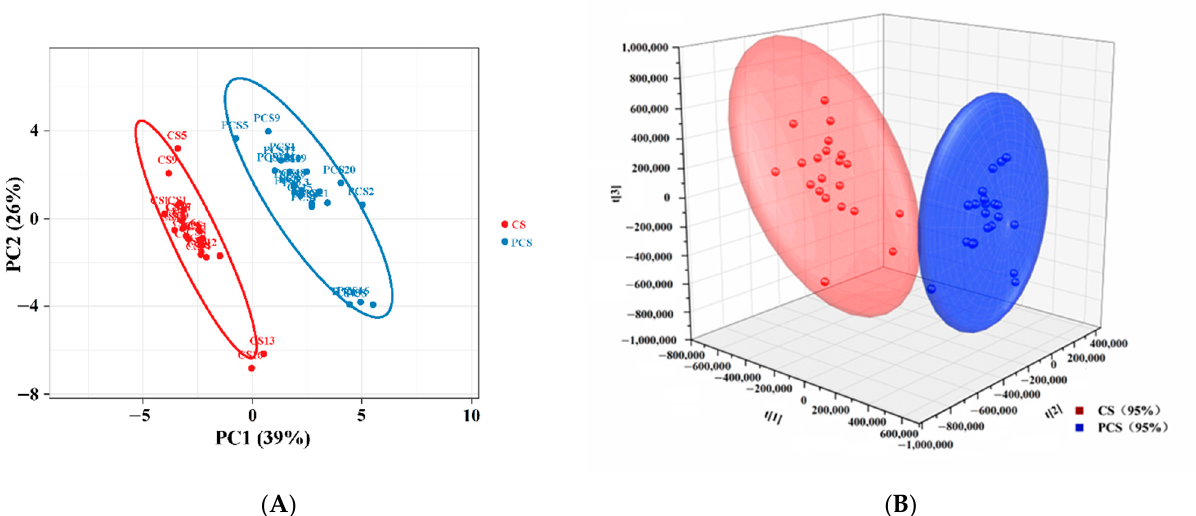
Figure 4. The score scatter plot (PCA) ( A ) and three-dimensional score scatter plot (PCA) ( B ) drawings of 21 batches of CS and PCS samples.